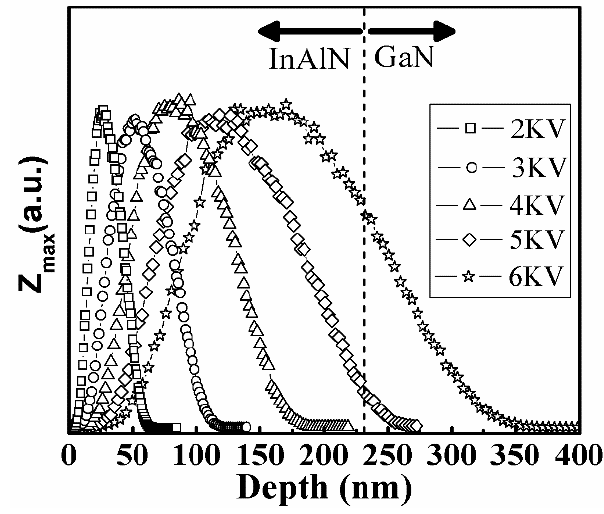
Figure 6. CL Monte Carlo simulation curve.